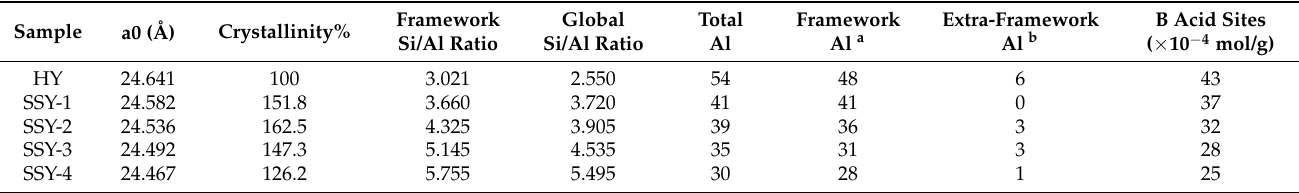
Table 2. The structural properties of the modified and parent zeolites.